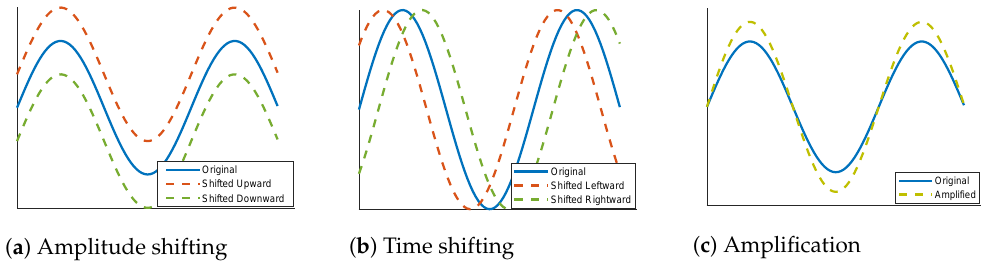
Figure 5. Data augmentation techniques applied to the classes PVC, SP, and UB of the ECG5000